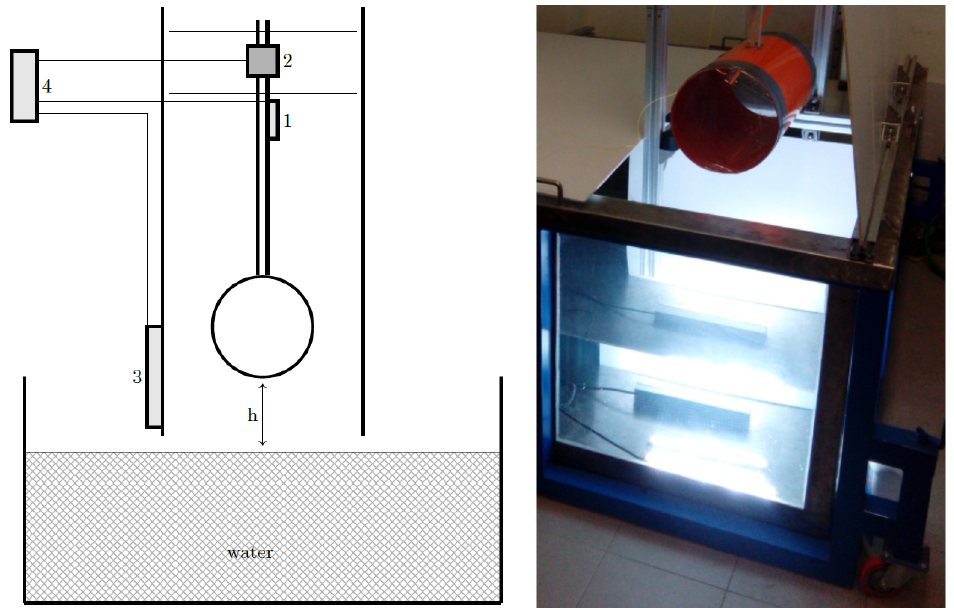
Figure 1. Scheme of the experimental setup ( left ): 1 — Fiber Bragg grating (FBG) connector, 2 — Accelerometer, 3 — Linear transducer, 4 — Data acquisition system. Picture of the experimental setup ( right ).